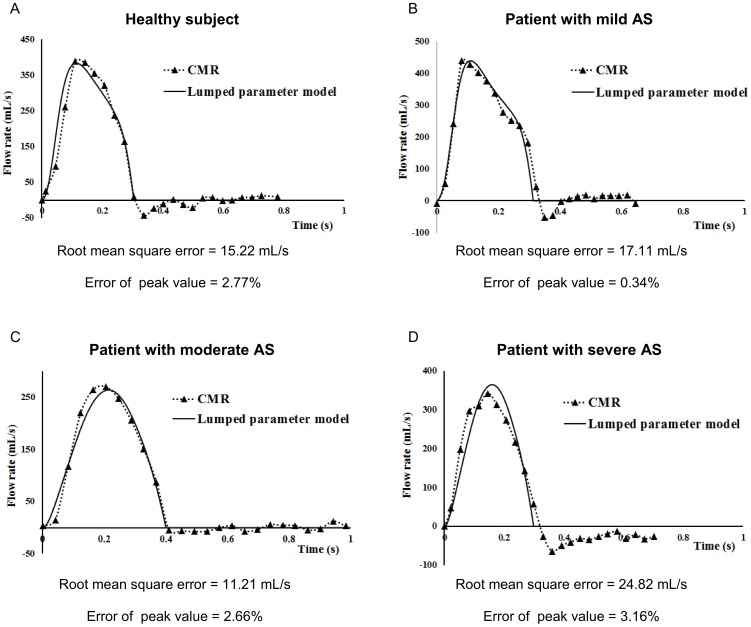
Comparison of simulated and CMR flow waveforms.(a) healthy subject, (b) patient with mild AS, (c) patient with moderate AS, (d) patient with sever AS.